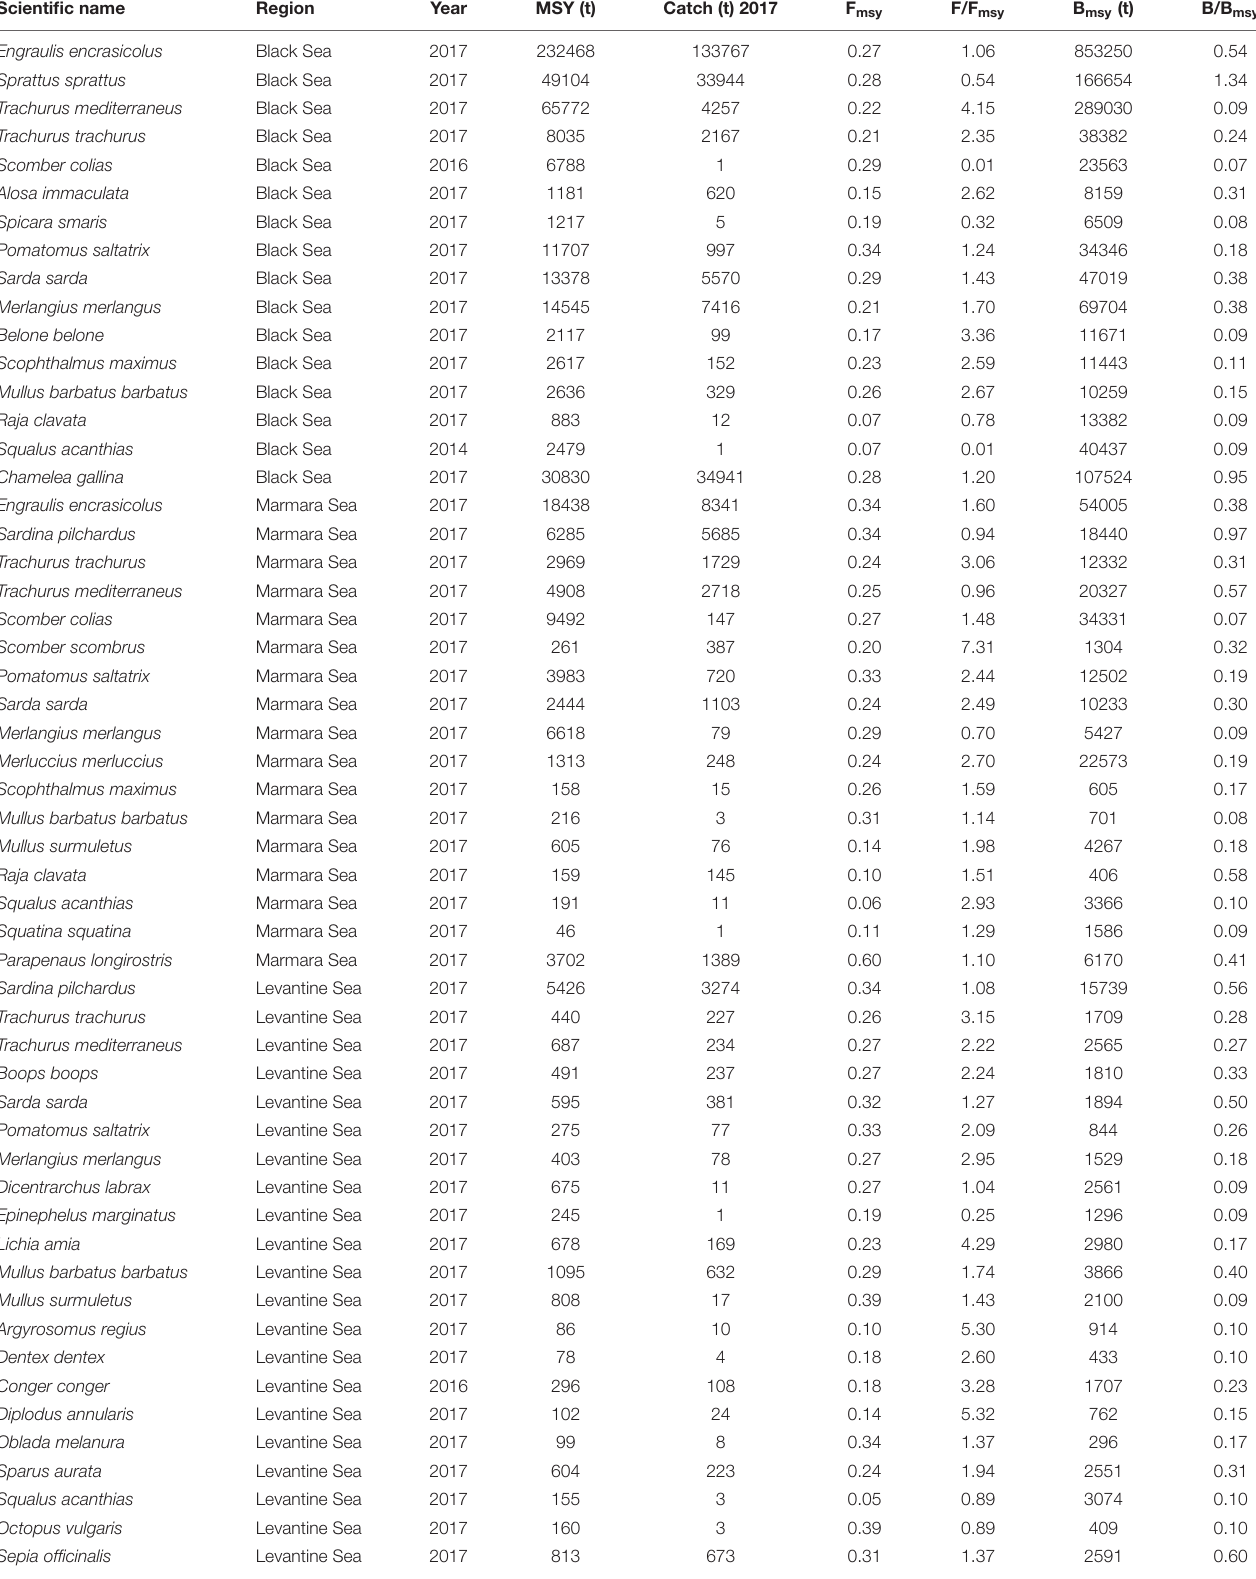
TABLE 4 | CMSY outputs for MSY, B msy , F msy , and r with stock indicators B/B msy and F/F msy for stocks in Turkish seas from